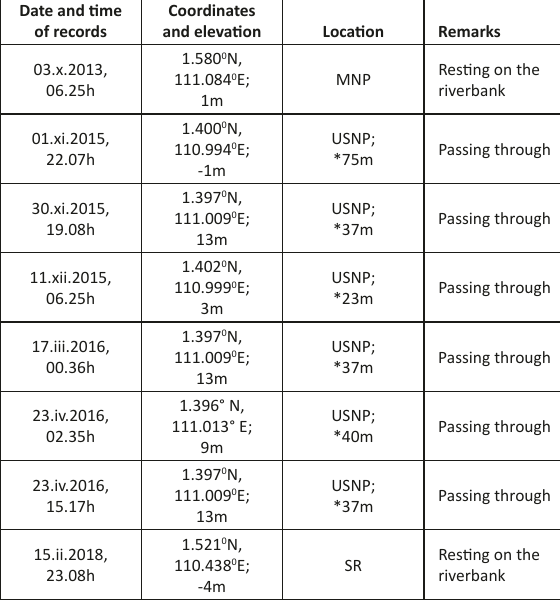
Resting on the riverbank